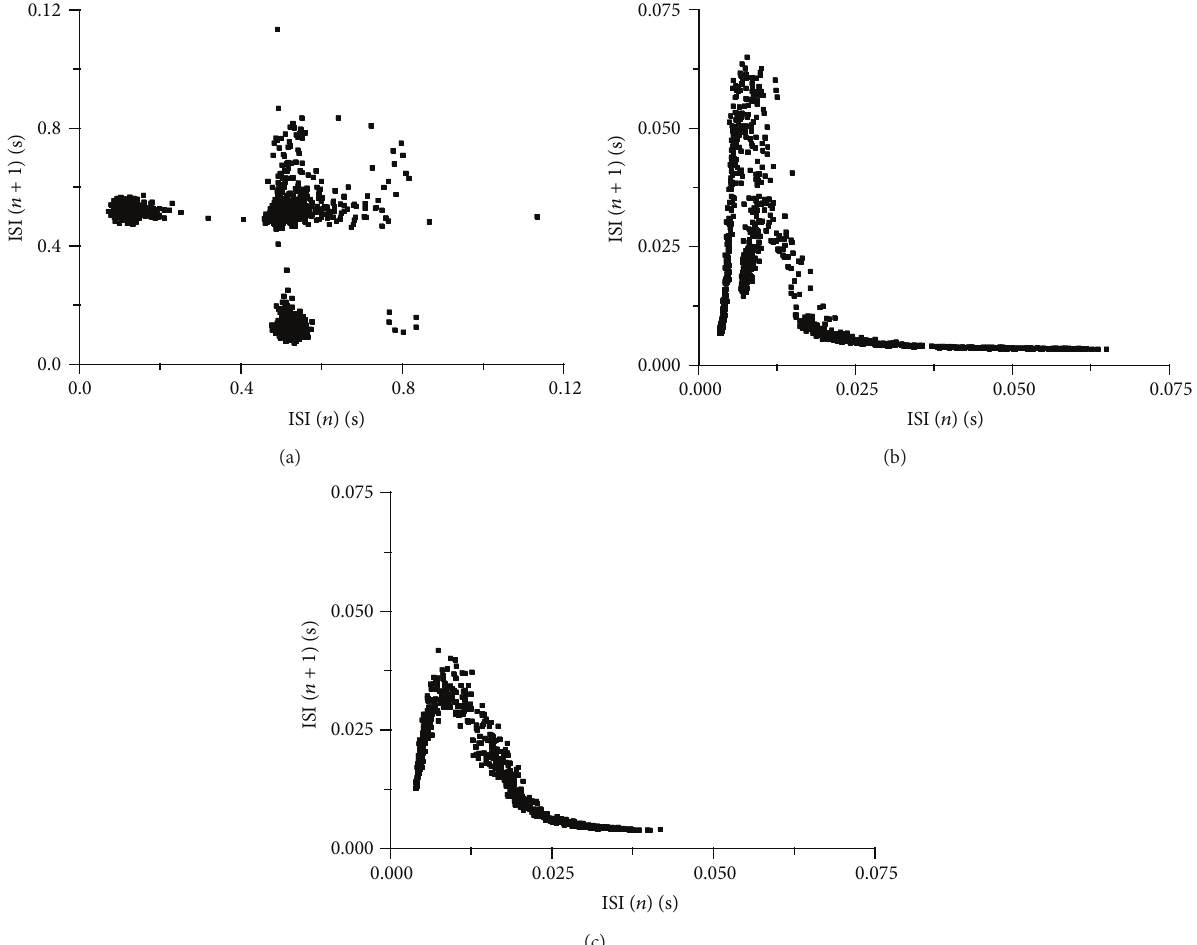
Figure 6: Example 2 of bifurcation scenario as observed from a pacemaker with decreasing [ Ca 2+ ] bursting to period-1 spiking. In detail, the process is from period-1 bursting to chaotic bursting to period-2 bursting to chaotic bursting to period-3 bursting to chaotic bursting to chaotic spiking to period-2 spiking to period-1 spiking. (b) Part of Figure 6(a); the process is from chaotic bursting to chaotic spiking.